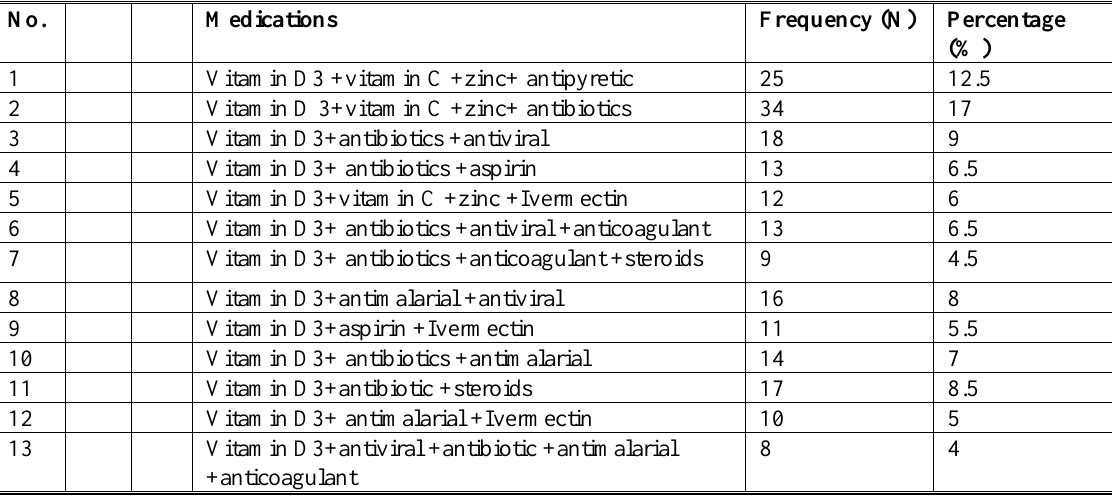
Table 2. Pharmacological protocols used for the